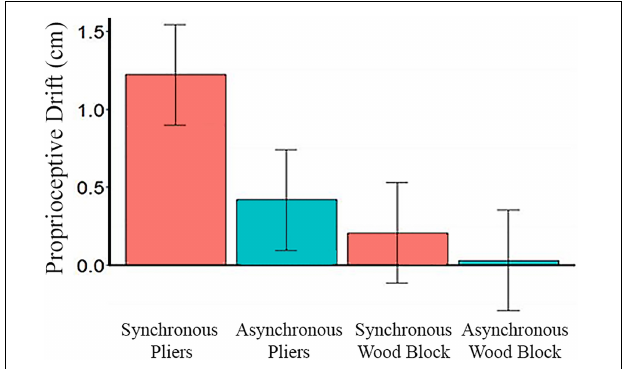
FIGURE 3 | The non-significant interaction of timing of visuo-tactile stimulation and viewed object. The significant main effect of viewed object is apparent, as drift was larger when participants viewed a rubber hand holding pliers than when a wooden block was viewed. Error bars represent ± 1 SEM.